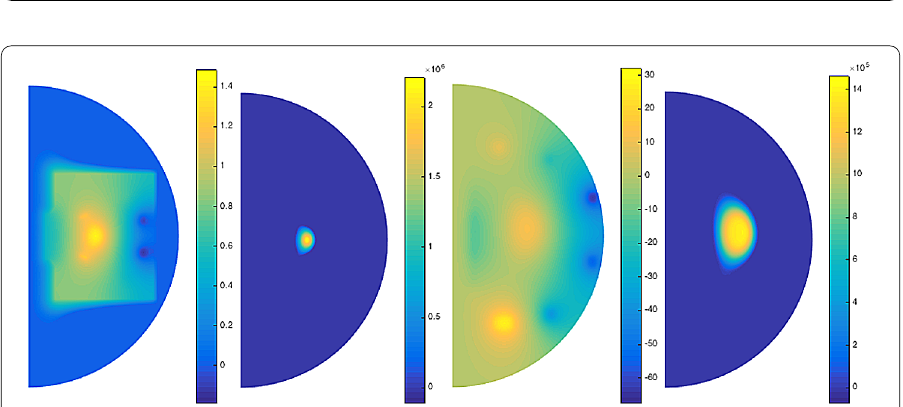
Figure 5 Example WEST and ITER: Contour Lines. Contour lines of the magnetic flux ψ for WEST (left) and ITER (right). The location ( r max ( ψ ), z max ( ψ )) of the maximum of ψ is indicated with a green circle. The location ( r X , z X ) of the discrete saddle points of ψ is indicated by black circles. The magenta line indicates the contour line that contains the plasma boundary